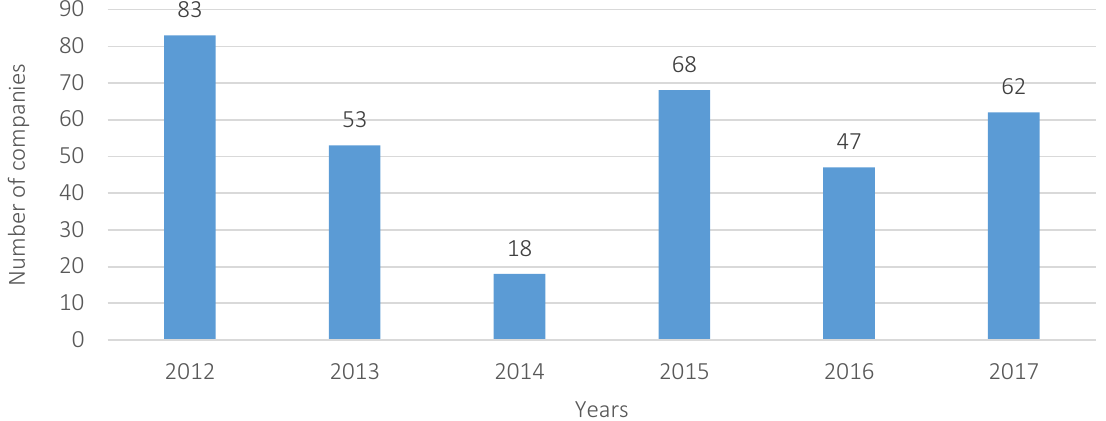
Figure 2. Number of companies with an output efficiency value of